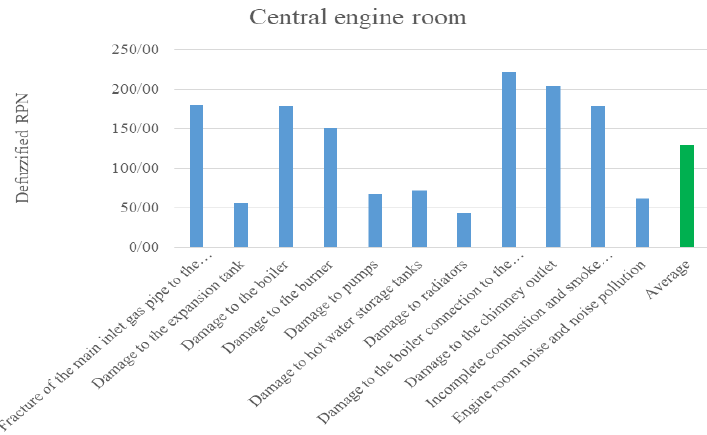
Figure 4. Defuzzified RPN values for the risk of CHBRs